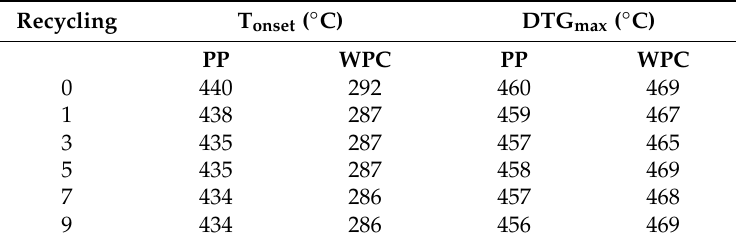
Table 1. Onset degradation temperatures (°C) and the maximum DTG peak temperature (°C) for PP and WPCs before and after recycling.